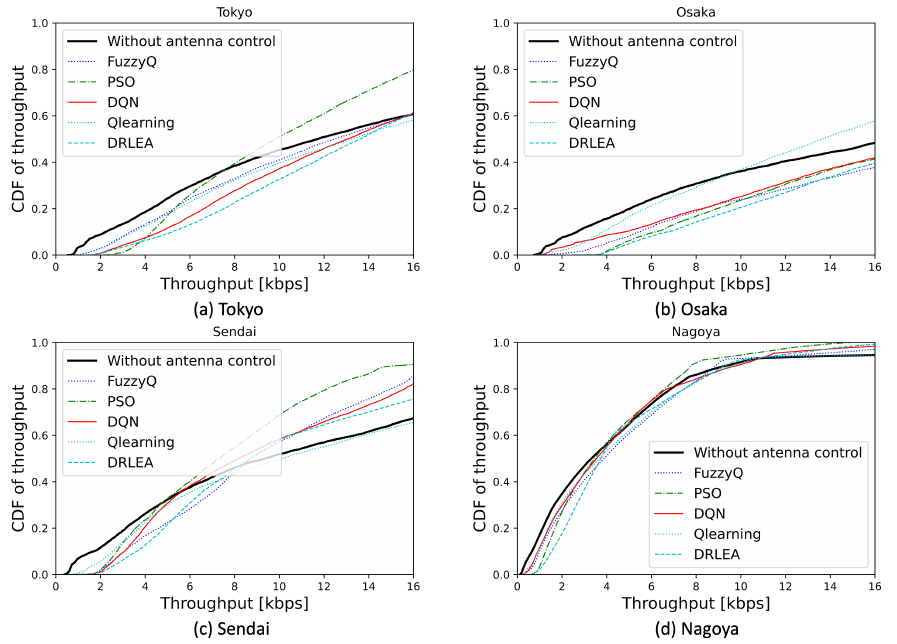
Figure 10. CDF of UE throughput performance under the HAPS with